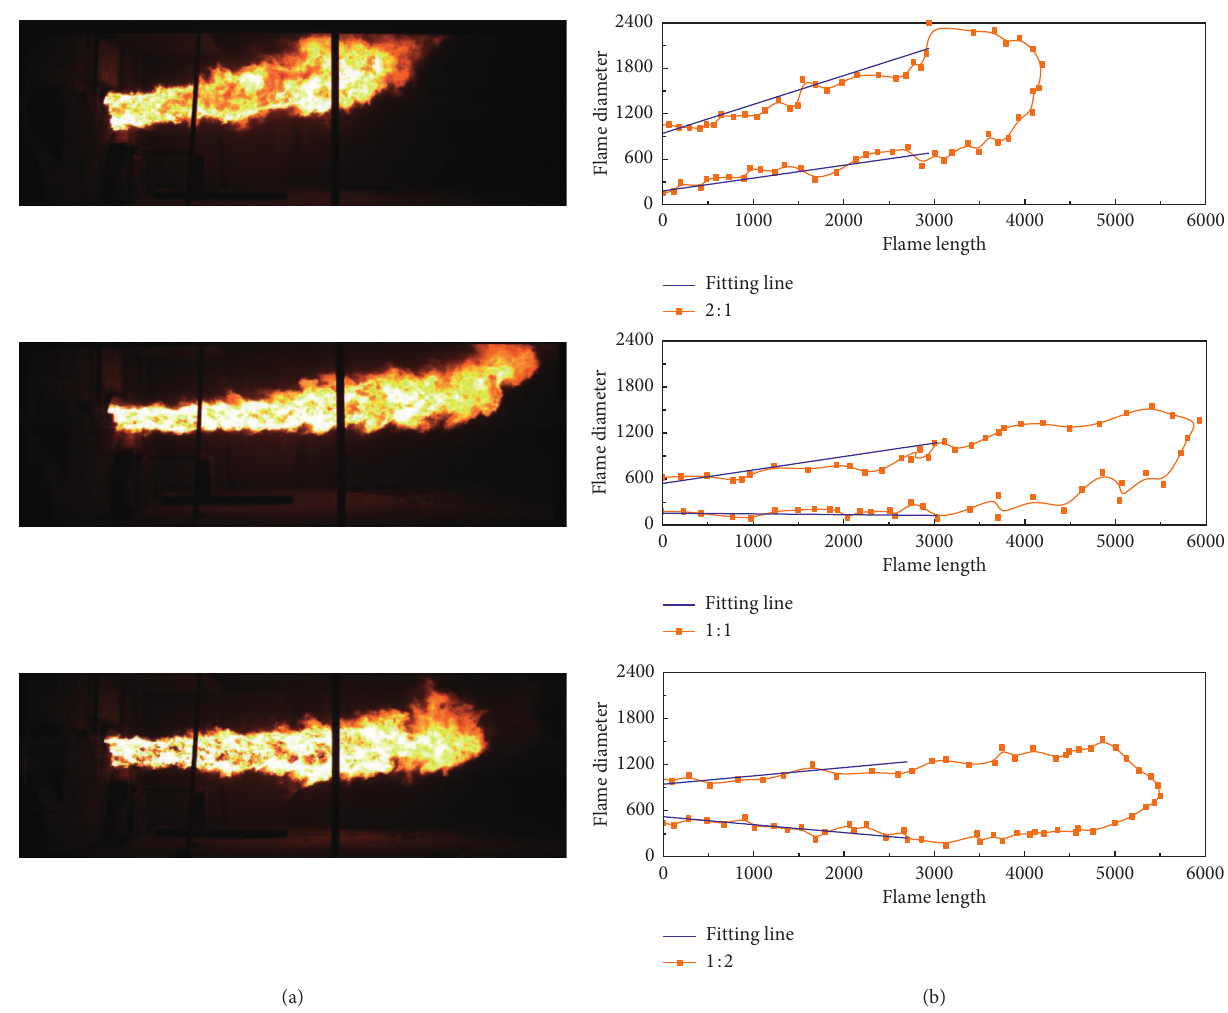
Figure 9: Flame shapes and profiles for different